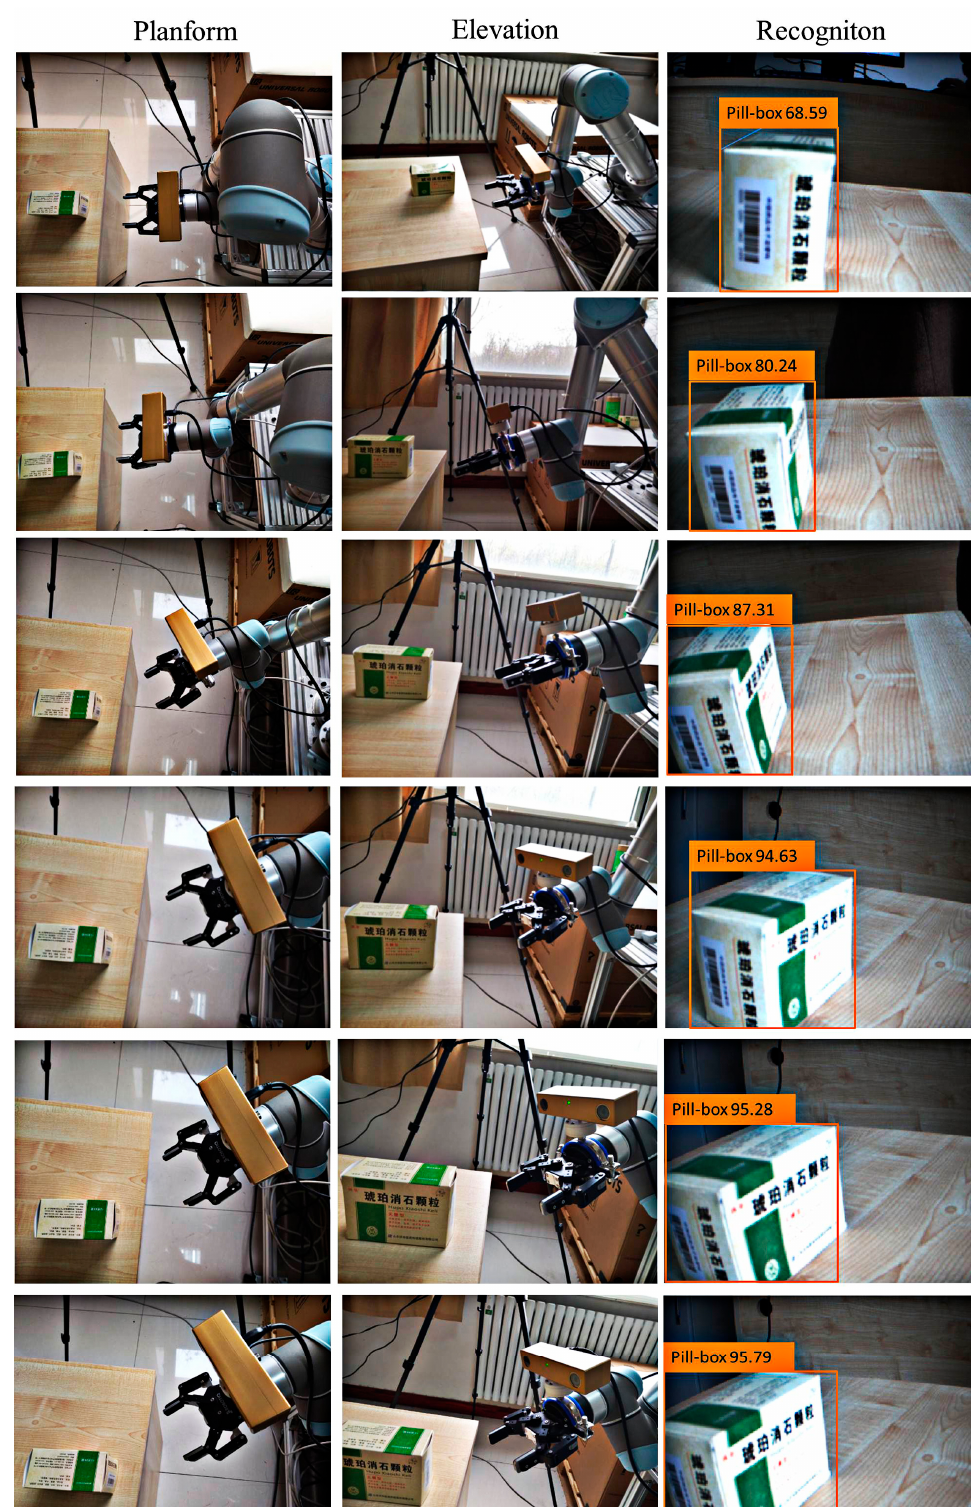
Figure 10. Viewpoint optimization path